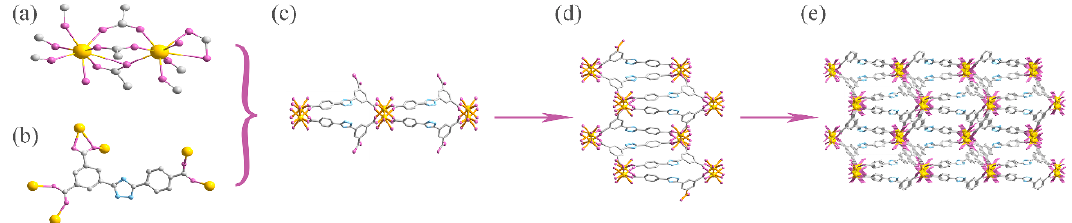
Figure 1. ( a ) Coordination environment of central Tb 3+ ions in 3 with hydrogen atoms for clarity. ( b ) Coordination mode of dcpcpt 3 − ligand. ( c ) 1D chain. ( d ) 2D network. ( e ) 3D framework.